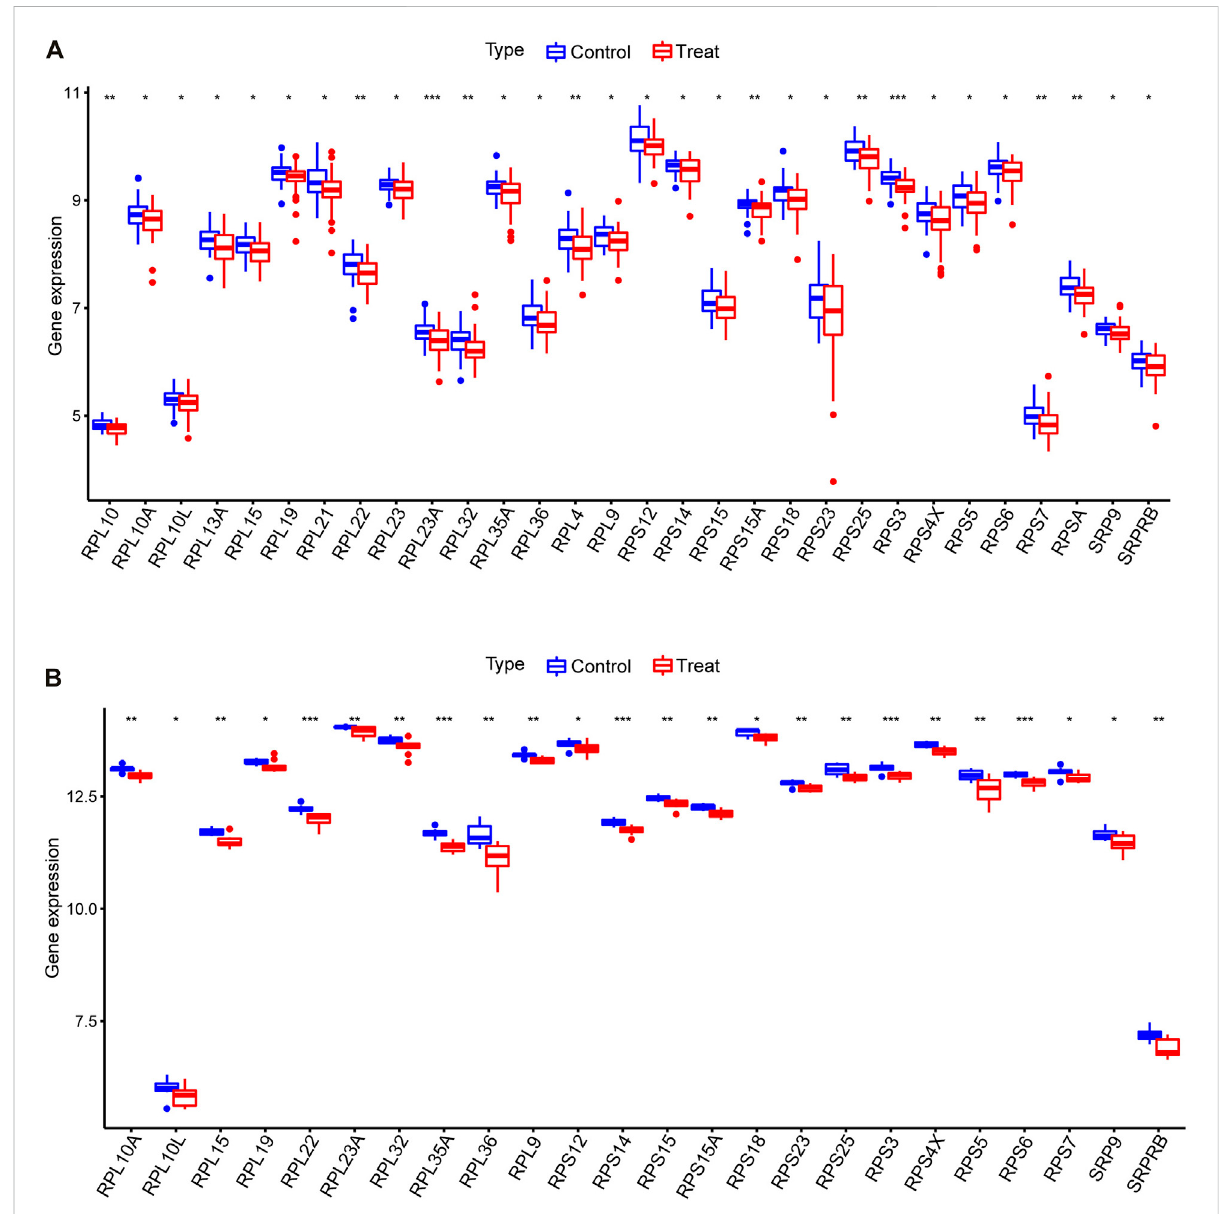
FIGURE 2 DifferentialanalysisofDE-SRPGs. (A) Boxplotof30DE-SRPGsinthetrainingset. (B) Boxplotofthe24DE-SRPGs(excludingthesixmissingDE- SRPGs) in the test set. Red denotes the treatment group, and blue denotes the control group. *, p < 0.05; **, p < 0.01; ***, p <